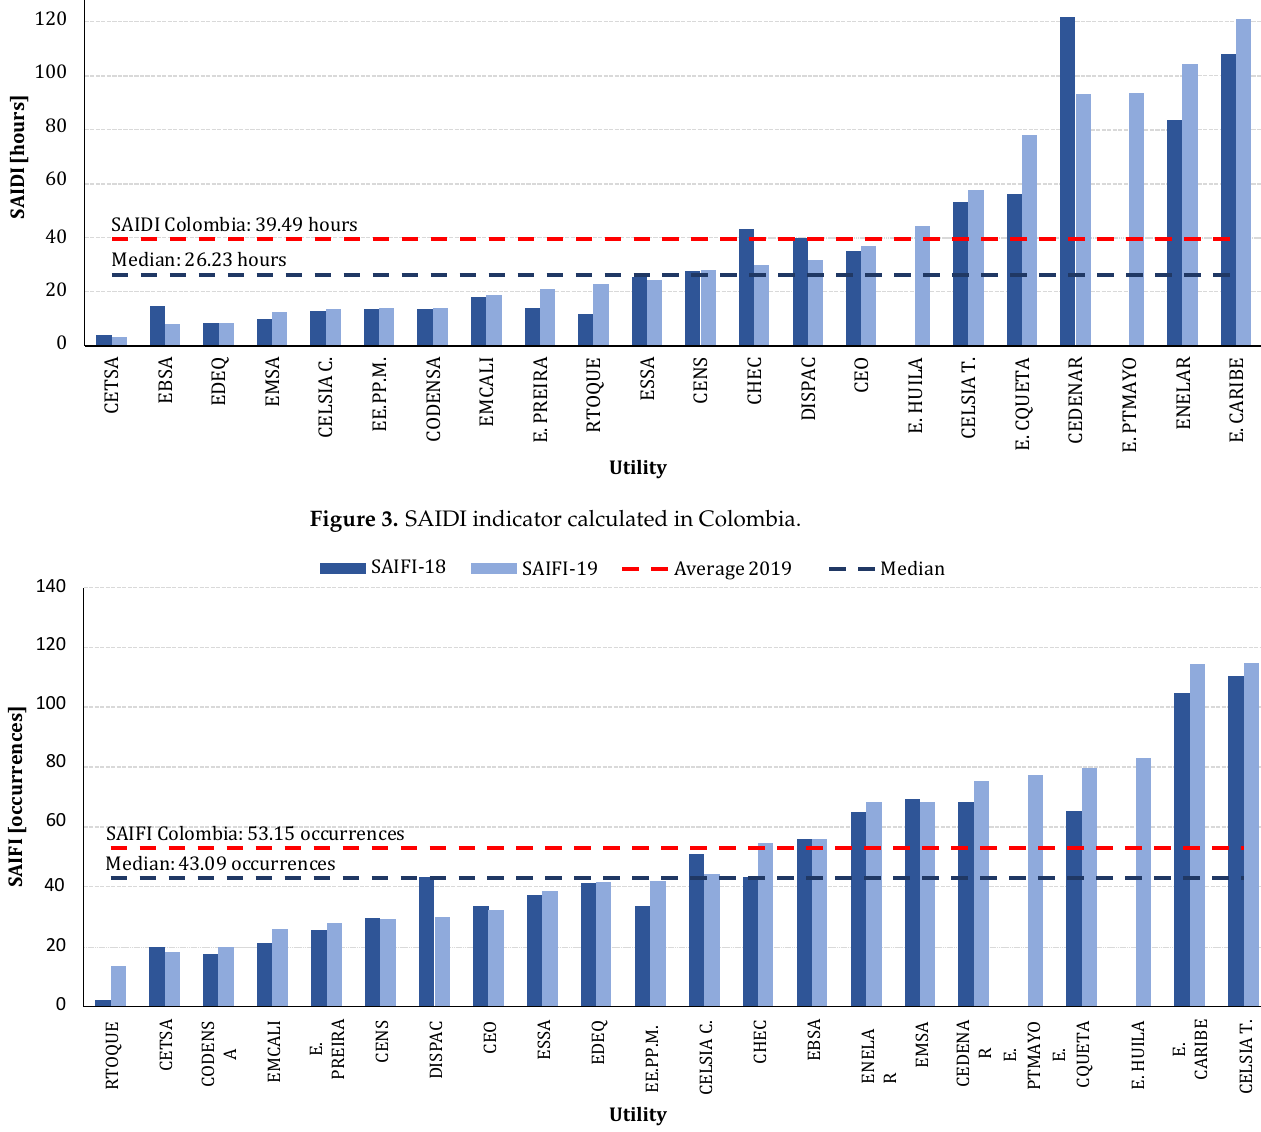
Figure 4. SAIFI indicator calculated in Colombia. Table 17. FMIK and TTIK indicators calculated in Ecuador.